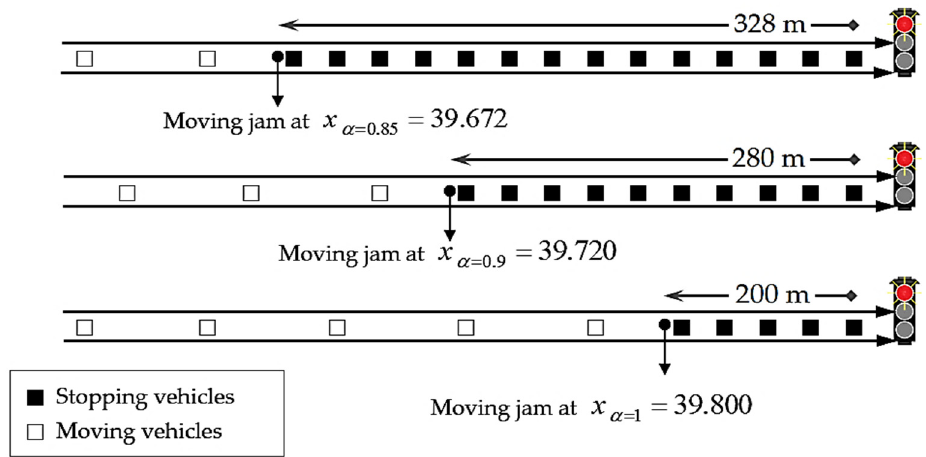
Figure 4. Three expected scenarios of the moving jam locations for various values of the fractional α . order α order